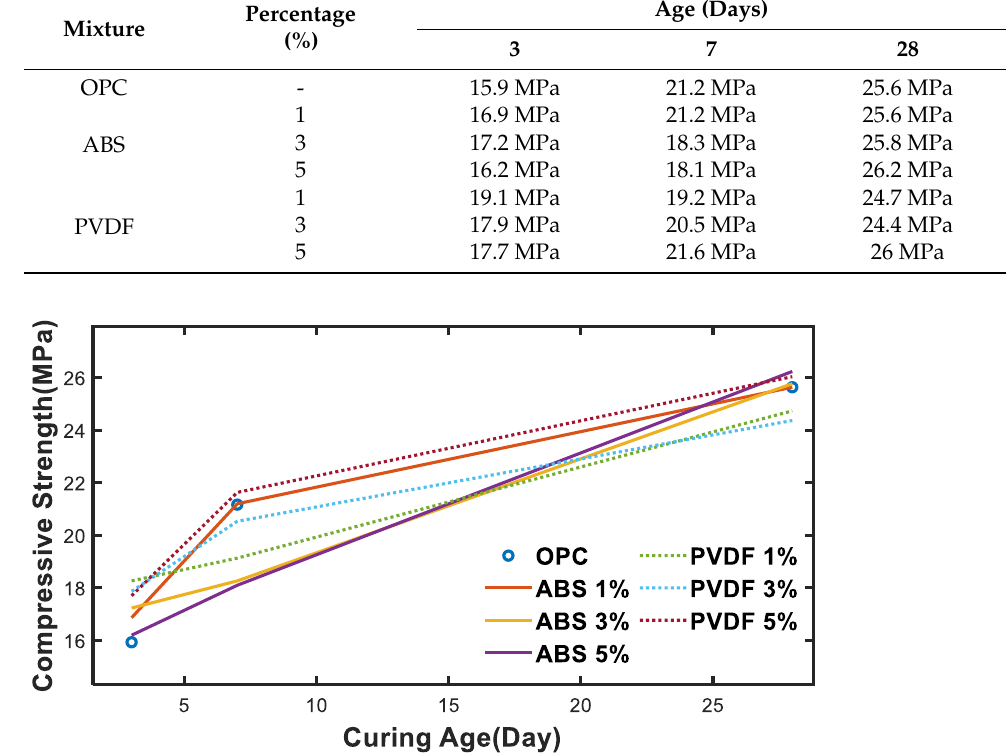
Table 7. Compressive strength by mixture addition and percentage.